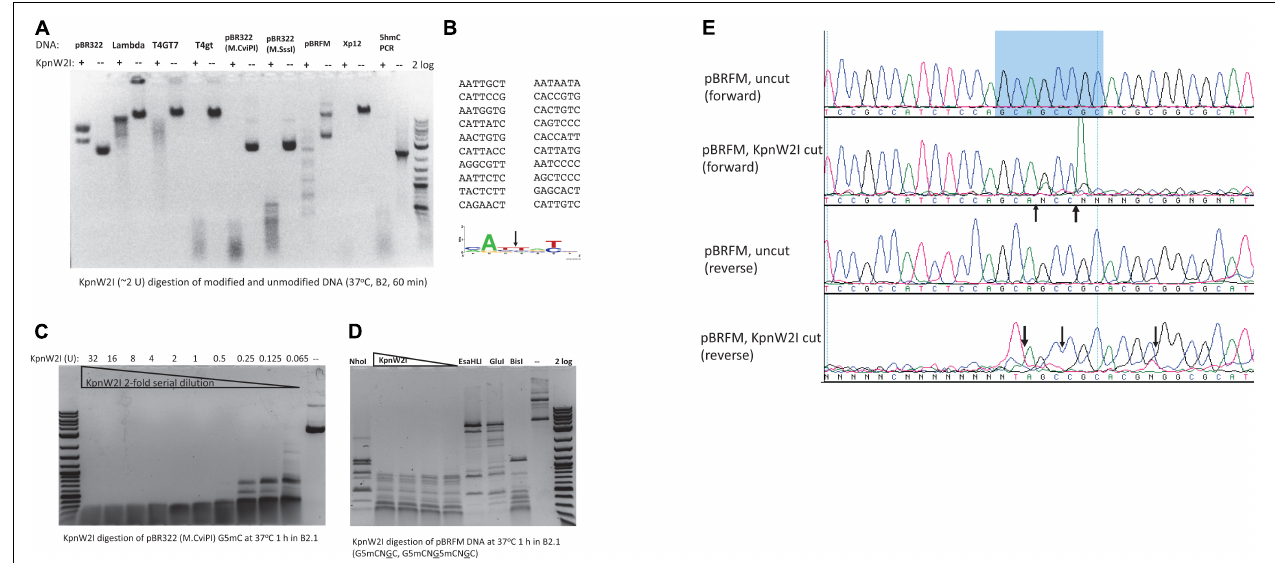
FIGURE 4 | KpnW2I digestion of modified and unmodified DNA substrates. (A) Restriction of modified and unmodified DNA. pBR322, phage λ , and T4GT7 were “unmodified”, except Dcm + ; T4gt and hm5C-PCR DNA contain hm5C; pBR322 (M.CviPI) is m5C-modified at GpC sites; pBR322 (M.SssI) is m5C-modified at CpG sites; pBRFM (pBR322- fnu4HIM ) is m5C-modified at GCNGC sites; phage Xp12 DNA contains m5C. “ + ” and “–" indicated presence or absence of KpnW2I endonuclease. Two units of KpnW2I were used to digest 0.5 µ g of DNA at 37 ◦ C for 1 h in B2.1. (B) Mapping of KpnW2I nicking sites to RY ↓ NRY in pBR322. (C) KpnW2I enzyme titration on M.CviPI-modified pBR322 (Gm5C). (D) Comparison of digestion patterns created by BisI family enzymes NhoI, KpnW2I, EsaHLI, GluI, and BisI. (E) Mapping KpnW2I cut site by run-off DNA sequencing. Arrows indicate the cleavage